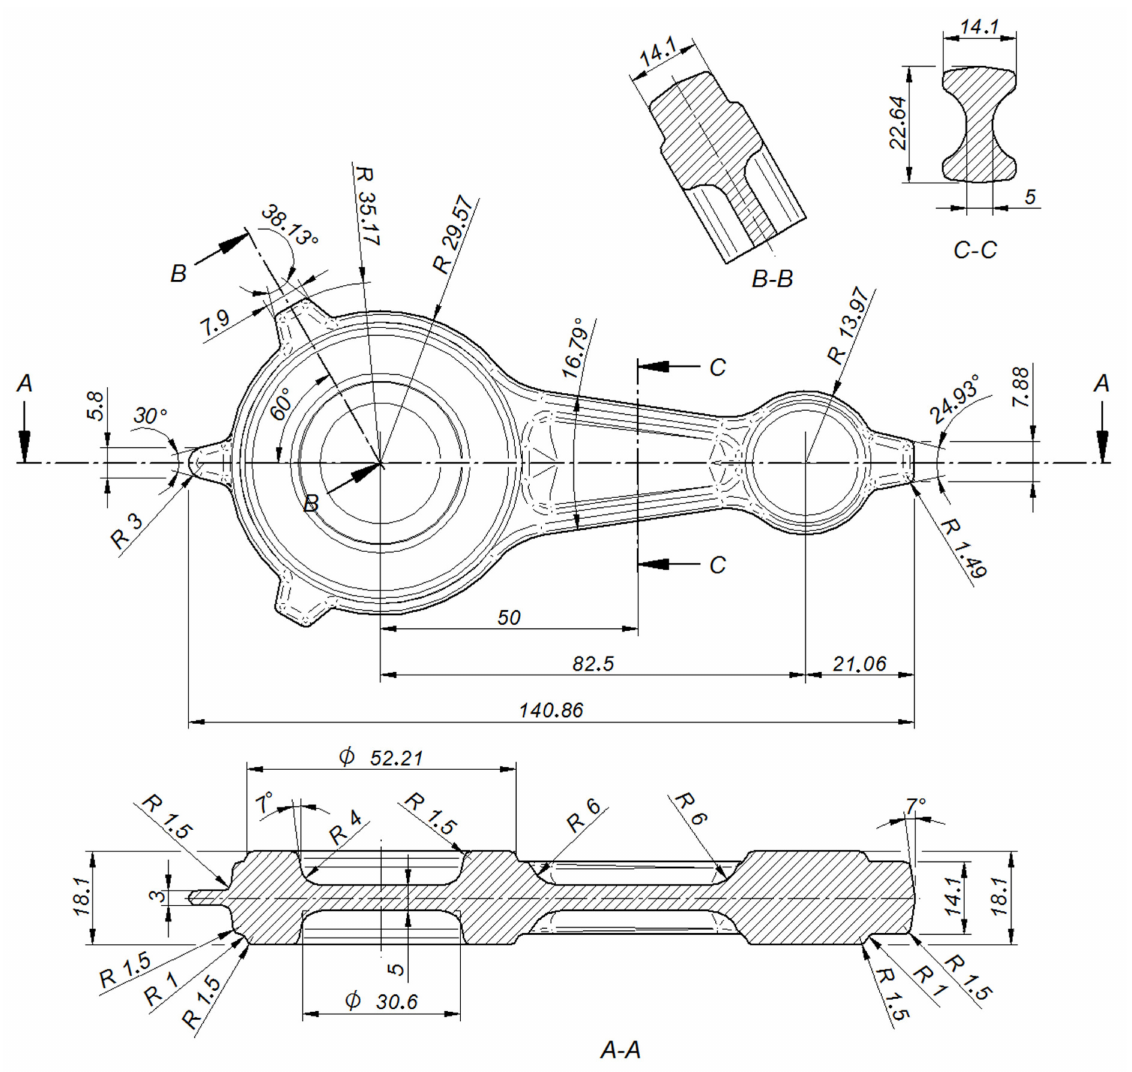
Figure 3. Selected dimensions of the connecting rod forging. The design of the forging process for the forging of the connecting rod from the cast preform commenced with the drawing of the cross-sectional diagram of the forging shown in Figure 4. The horizontal axis labeled “length of forging/preform [mm]” presents the distance of individual cross-sections of the forging/preform from the origin of the coordinate system. The vertical axis labeled cross-sectional area (mm 2 ) presents the size of the forging/preform cross-sectional area. Two preforms (variants 1 and 2) were designed based on the cross-sections of the forging, the outline of the forging in the die parting plane, and by changing the characteristic dimensions of the forging (see Figures 5–8). The cross-sectional areas of the designed preforms are compared with the forging in Figure 4. The designed preforms differ primarily in height and thus in the degree of forging, cross-sectional dimensions in the die parting plane and volume. For variants 1 and 2, the degree of forging defined by the ratio of the height of the preforms to the height of the forging is h 1 /h 0 = 1.93 and h 2 /h 0 = 1.43, respectively (Figure 5). The volume of variant 1 preform shown in Figure 6a is 67,437.2 mm 3 (the mass is 0.192 kg), while that of variant 2 preform shown in Figure 6b is 71,743.6 mm 3 (the mass is 0.204 kg). As assumed, the forging of the connecting rod forging from the cast preform will take place only in the finishing impression of the